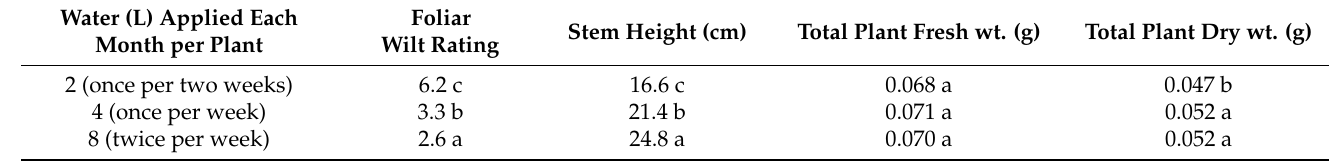
Table 1. Influence of irrigation regime on the foliar wilt of perennial herbs and the resulting growth characteristics in an extensive green roof